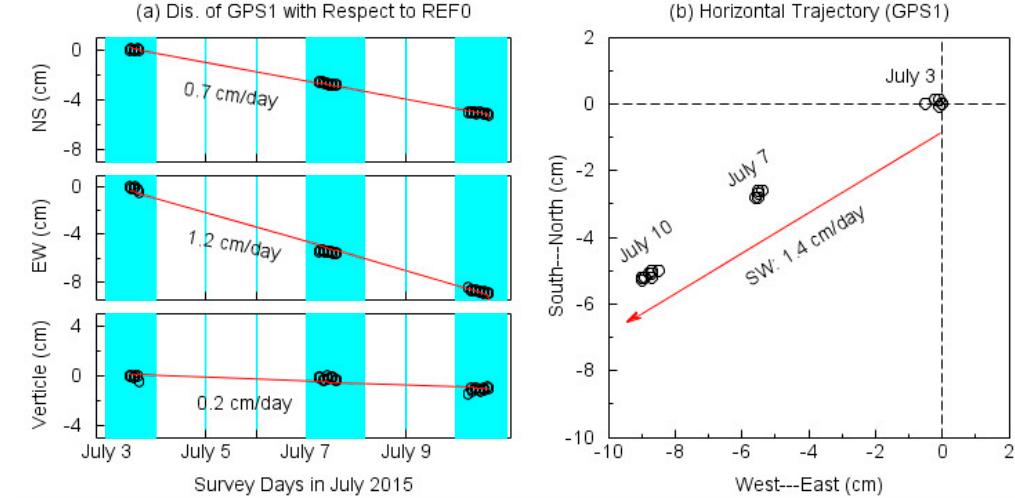
Figure 7. ( a ) Three-component (NS: north to south, EW: east to west; Vertical) displacement time series of the GNSS antenna (GPS1) during the period from 3 to 10 July 2015. The displacements are referred to a GNSS station (REF0) located outside of the sliding mass. ( b ) The horizontal trajectory of the GNSS antenna (GPS1) during the same period as ( a ). Locations of GPS1 and REF0 are marked in Figure 3b.